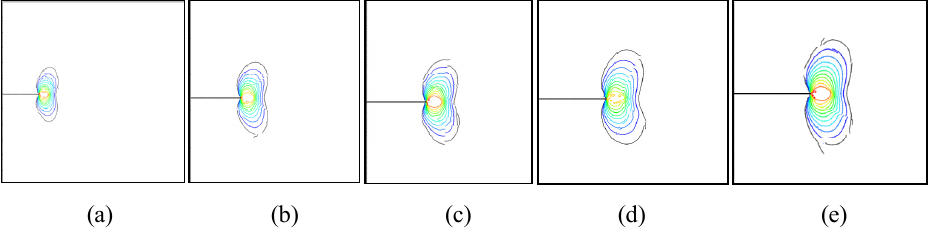
Figure 13. Shape of the plastic zone at the crack tip under plane stress: ( a ) grain gradient of 0.5; ( b ) grain gradient of 0.4; ( c ) grain gradient of 0.3; ( d ) grain gradient of 0.2; ( e ) grain gradient of 0.1.